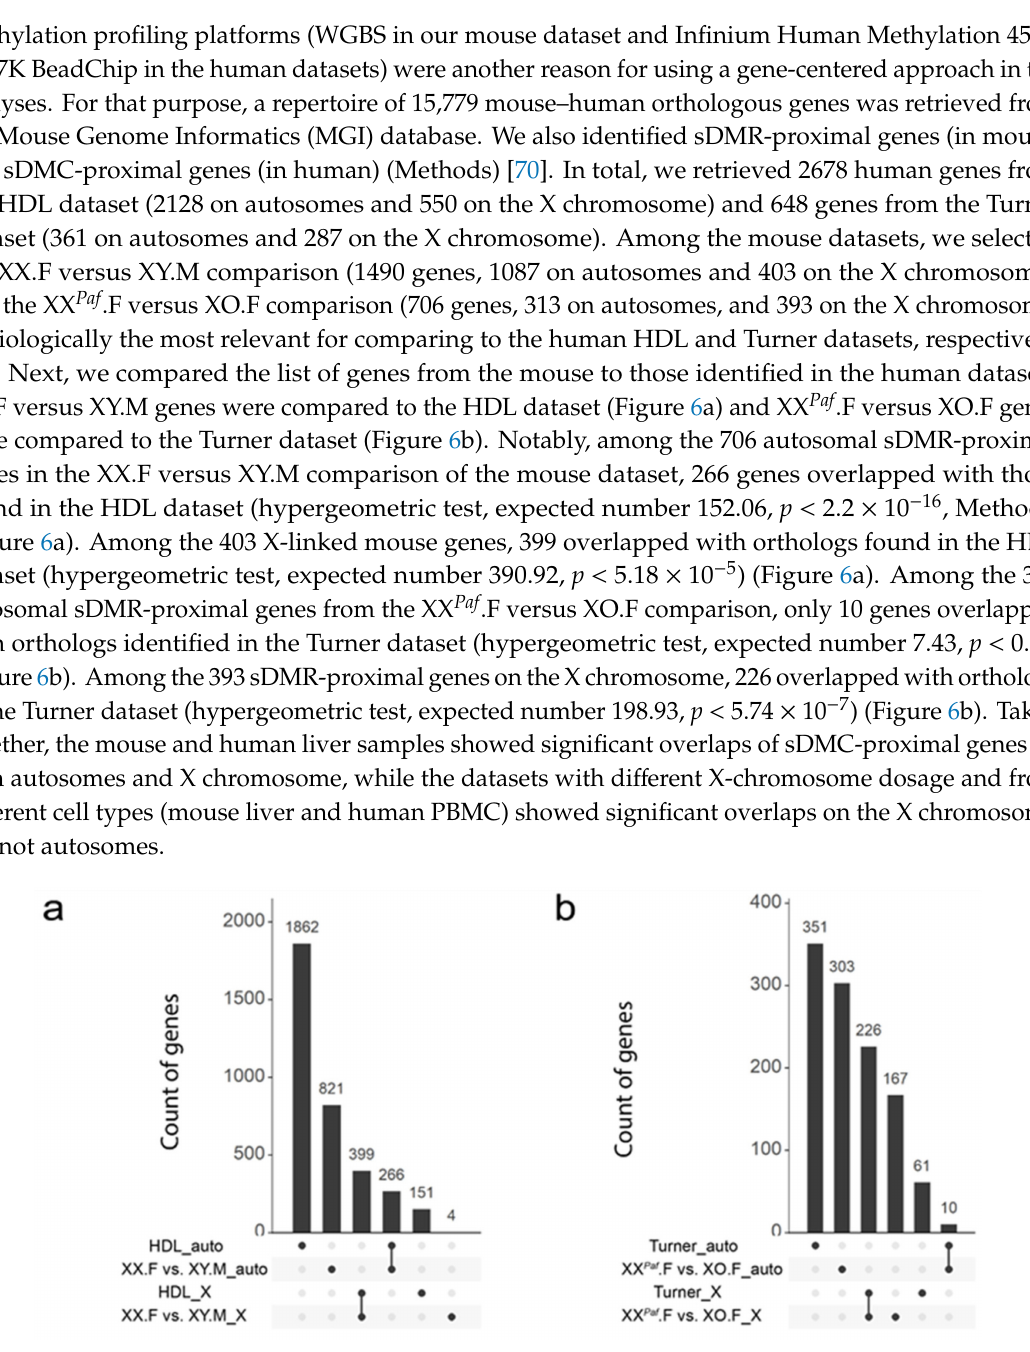
Figure 6. Mouse and human datasets show significant overlap of orthologous genes associated with di ff erential methylated cytosines. UpSet Plot shows the overlap of sDMR-proximal orthologous genes across comparisons. Each horizontal bar on the left represents the total number of sDMR-proximal orthologous genes identified in each comparison. ( a ) Overlaps of sDMR-proximal orthologous genes between the mouse and the human HDL datasets. The top two rows represent genes on autosomes and the bottom two rows represented genes on the X chromosome. ( b ) Overlap of sDMR-proximal orthologous genes between the XX Paf .F versus XO.F comparison and the human Turner dataset. The top two rows represent genes on autosomes and the bottom two rows represent genes on the X